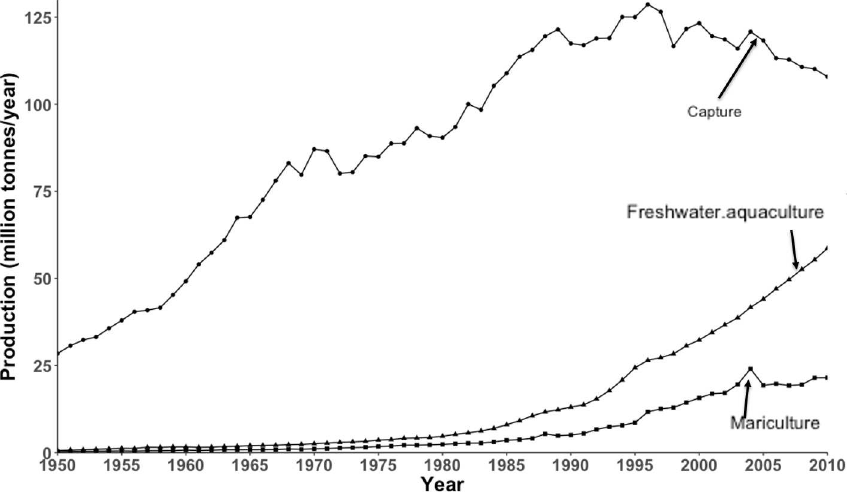
Fig 1. Global trends in food fish production from 1950 to 2010 with production from capture fisheries, freshwater aquaculture and mariculture. Data from Sea Around Us (2010) and FAO